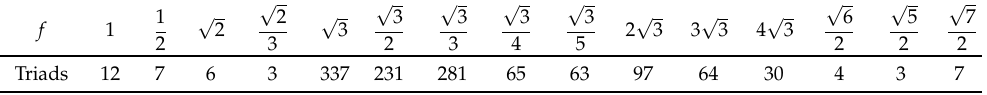
Table 2. Number of irreducible triads against different values of aspect ratio f